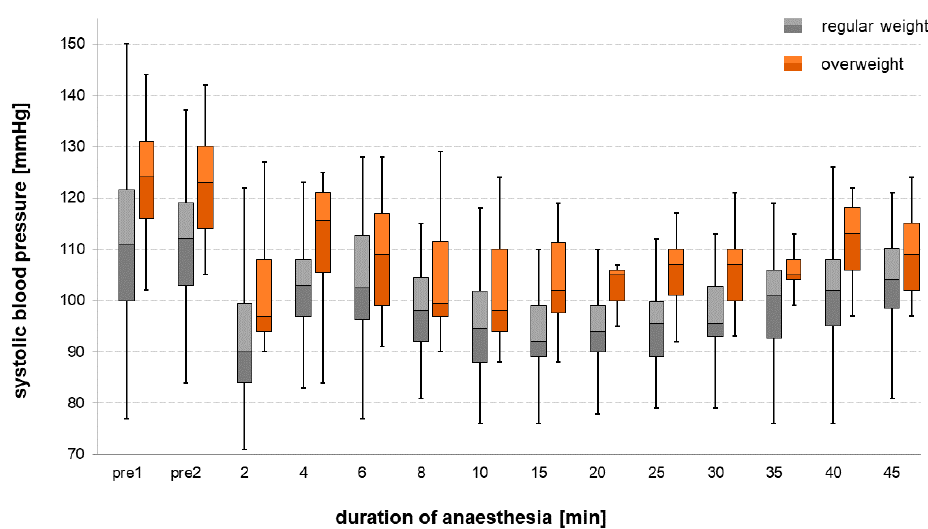
Figure 3. Systolic blood pressure over time during the course of anesthesia comparing the two groups “regular weight” and “overweight” represented in boxplots. The patients in the overweight group had a significantly higher systolic blood pressure during the course of anesthesia (except for measurements 6 and 8 min after the induction of anesthesia), with a drop in both groups 2 min after the administration of propofol. Pre1 and pre2 stand for blood pressure measurements before anesthetic induction—the minutes to the right of these stand for the time span from the initial administration of propofol. Table 3. Correlation of preoperative systolic blood pressure with di ff erent preoperative hormone levels. Correlation of Preoperative Systolic Blood